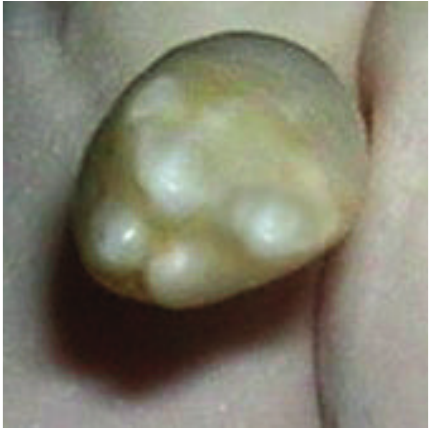
Figure 3: Molariform mesiodens after